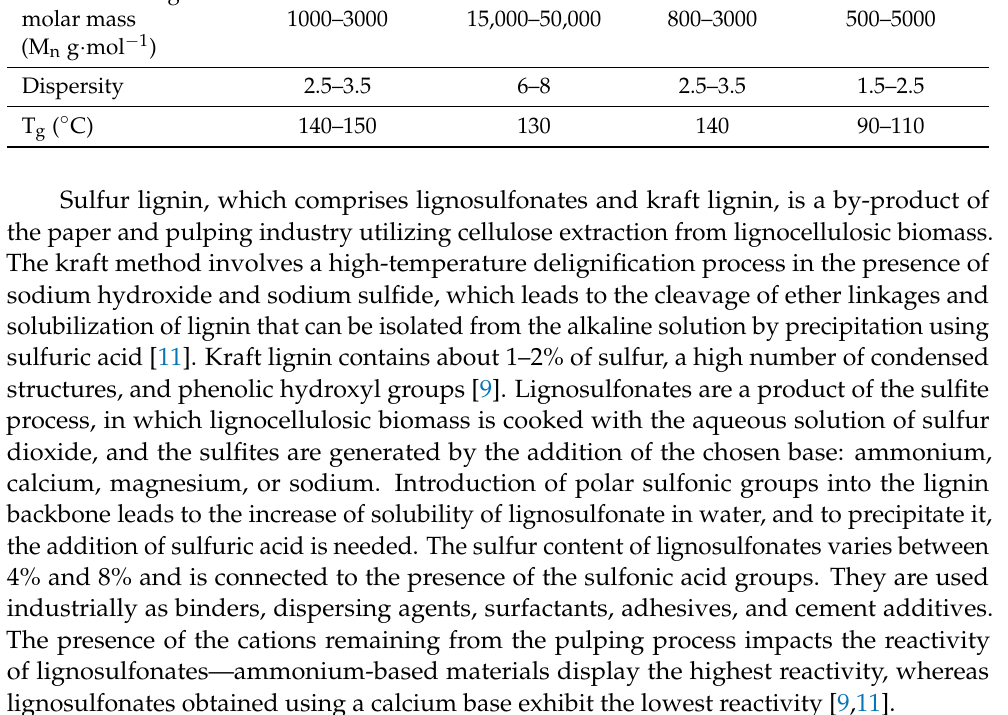
Table 3. Typical properties of technical lignin. Reproduced from [9], with the permission of Else- vier.